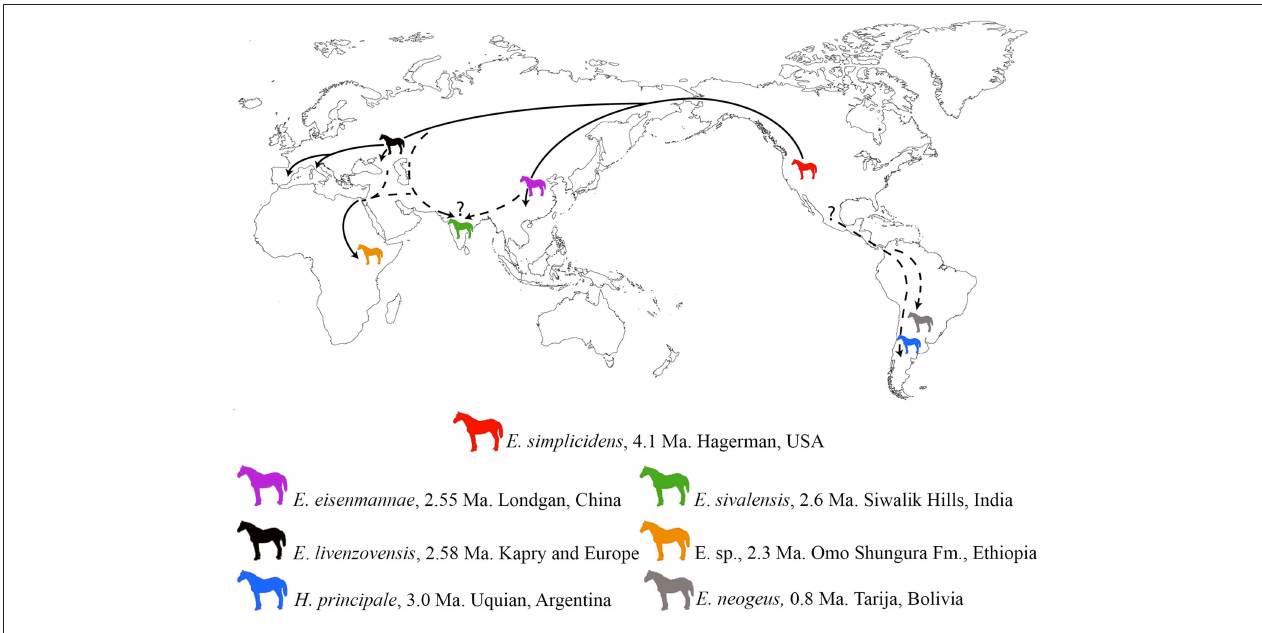
FIGURE 3 | Biogeographic extension of early Equus species across the five continents, with timing of early record of each